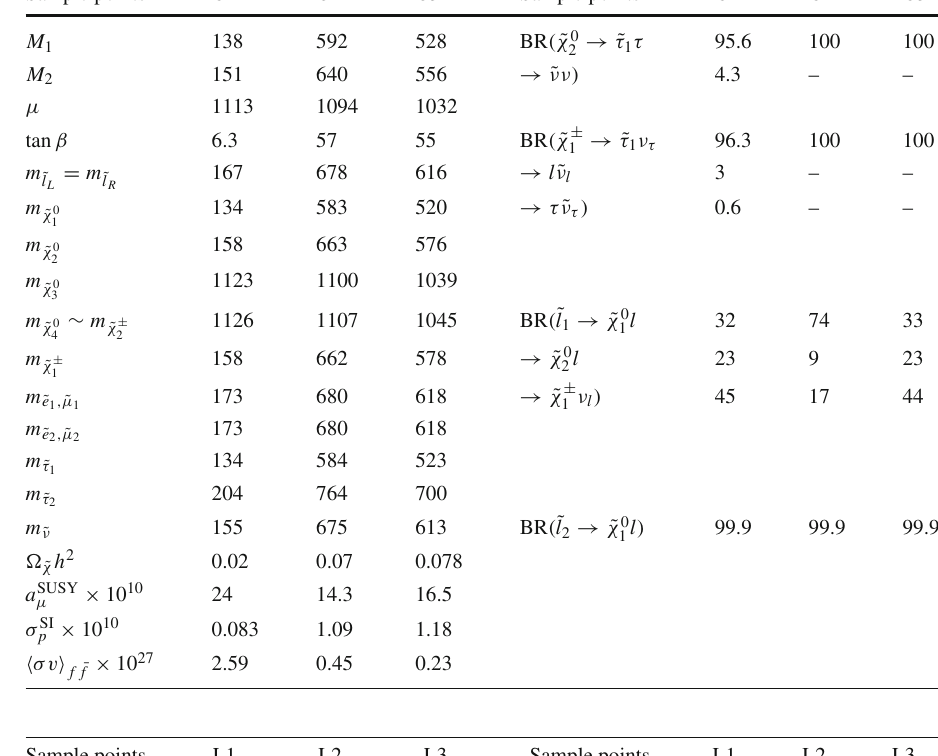
Table 4 The masses (in GeV) and relevant BRs (%) of three points from ˜ l ± -coannihilation scenario Case-L corresponding to the lowest LSP mass, the highest LSP mass with current ( g − 2 ) μ constraints, as well as the highest LSP mass with the anticipated future ( g − 2 ) μ constraint. The notation, definitions and units are as in Table 1. Only BRs above 0 . 1% are shown. The values of (cid:7) σv (cid:8) are given for f = τ for f ¯ f L1 and f = b for L2 and L3, corresponding to the dominant DM annihilation channel for the respective parameter